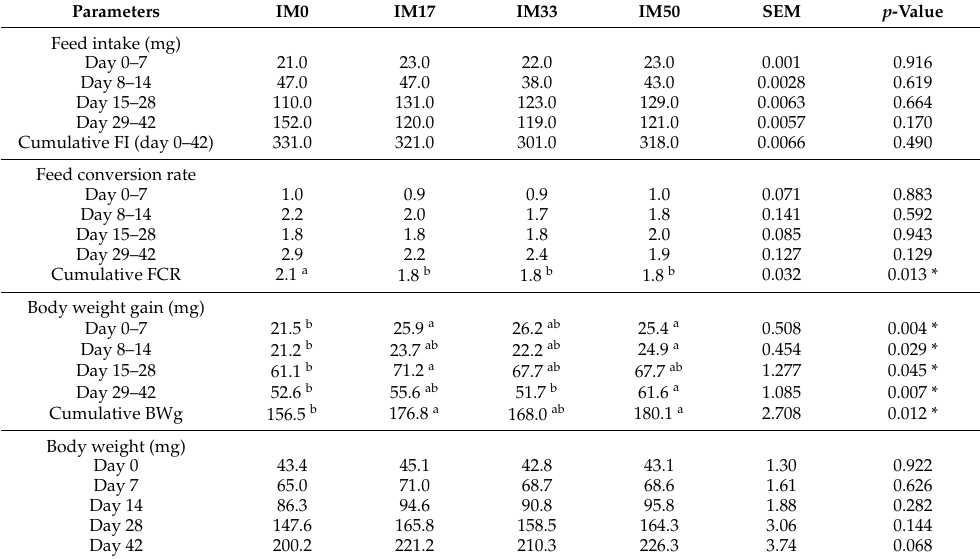
Table 3. Growth performances of the fish fed with different Hermetia illucens meal (IM) dietary inclusion and FM replacement rates.